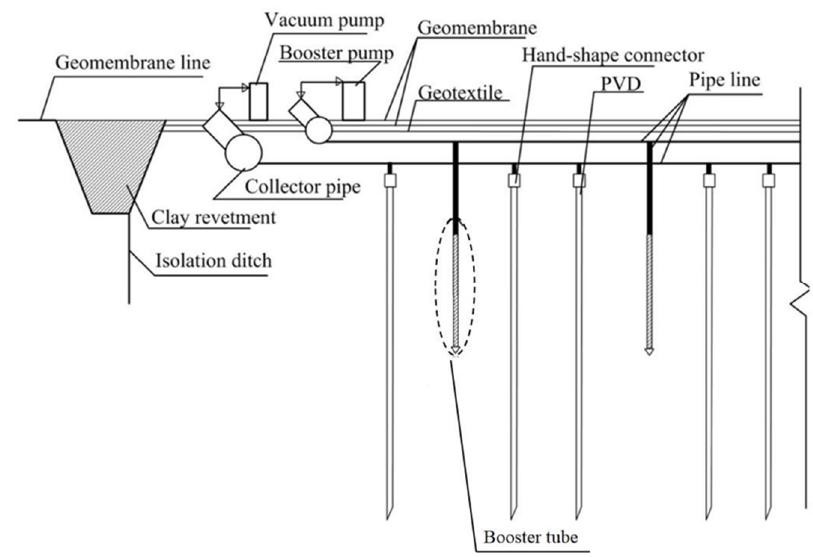
Figure 1. Configuration of the air ‐ booster vacuum preloading method.